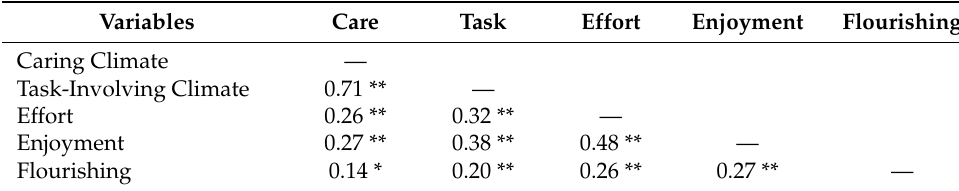
Table 2. Correlations of latent